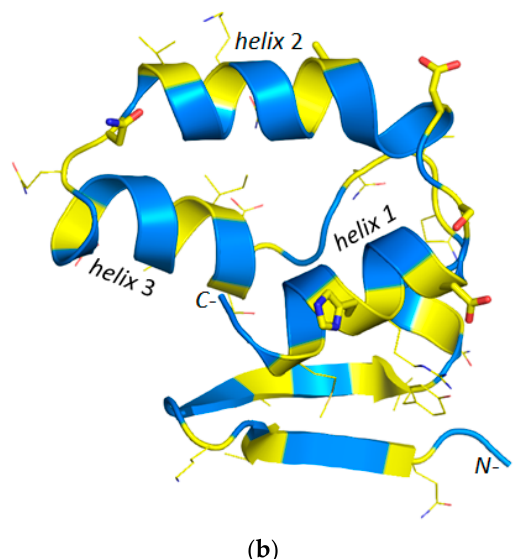
Figure 8. ( a ) Alignment of amino acid sequences of representative naturally occurring human or bat MARV and RAVV NP C-termini with date ranges of sampling, with the Kween MARV outbreak in 2017 [24] and MLAV [20] updating Figure 5a of [18]. Shown below are the secondary structures occurring in our Musoke crystal structure. Numbering uses the MARV/RAVV scheme since MLAV has two extra amino-acids elsewhere in NP. Mutations predicted to directly impact sdAb contacts are indicated with yellow ovals. MARV Musoke 1980, Angola 2005, and Leiden 2008 are equivalent to Ci67 in the region of NP shown (i.e., residues 632–695). ( b ) Pymol [25] rendering of a cartoon of the MARV Musoke NP C-terminal domain as bound by sdAb A (PDB ID: 6APP_B), with residues predicted to mutate between MARV and MLAV shown in yellow as lines (non-sdAb contacts) or sticks (contacts).